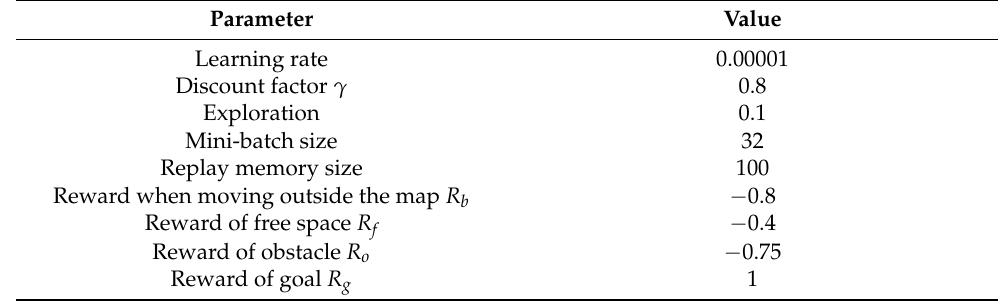
Figure 8. Training environment simulated using the proposed model. ( a ) An 8 × 11 grid map; ( b ) 11 × 33 grid map. Table 1. Training